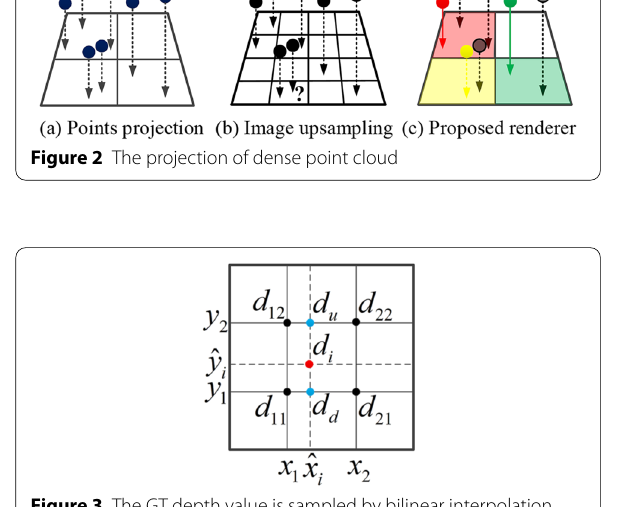
Figure 3 The GT depth value is sampled by bilinear